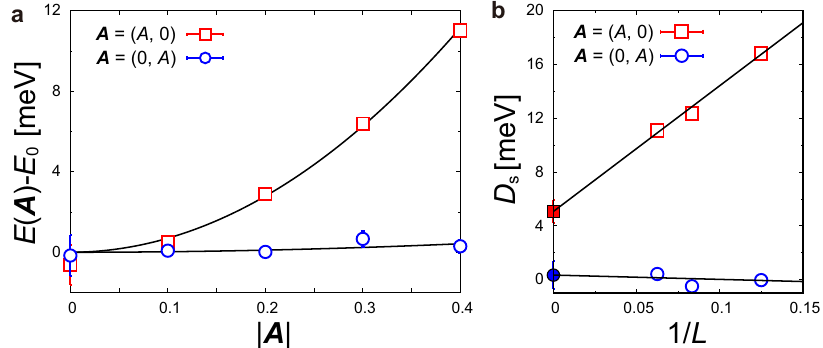
Fig. 4 Spin Drude weight D s for X = EtMe 3 Sb obtained by using the VMC method. a Vector potential dependence of the total energy with L = 16 for the QSL of X = EtMe 3 Sb. Squares and circles are the results in x and y directions, respectively. D s is obtained by fi tting the total energy shown here in the form E ( A ) = 2 π D s ∣ A ∣ 2 + E 0 as shown as the dashed lines. The energy unit is eV. We fi nd a substantial curvature of the energy in x direction for the QSL, indicating a large D s for the QSL. In all the data plot, error bars obtained in the VMC calculation are plotted and if not they are smaller than the symbol size. b System size dependence of D s in x (squares) and y (circles) directions for the QSL. Filled symbols represent D s in the thermodynamic limit, which are obtained after the linear extrapolation. Error bars arising from the fi tting or the extrapolation are plotted and if not they are smaller than the symbol size.